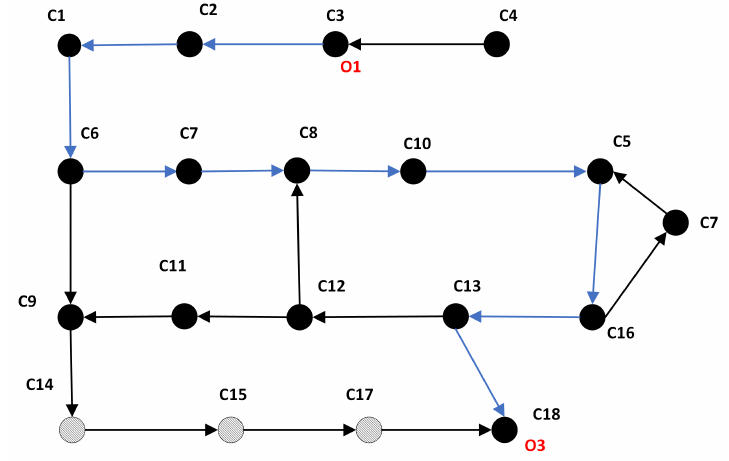
Figure 9. The shortest path between O 1 and O 3 considering the cells’